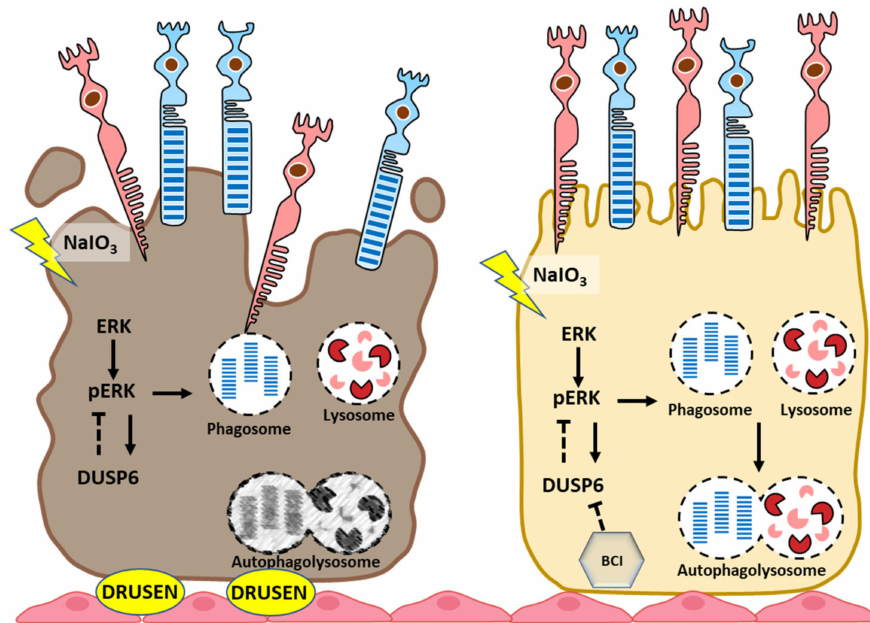
Figure S3: Immunohistochemical examinations of the expression of Iba1 in NaIO 3 -treated mice retina. Representative immunohistochemical staining for Iba-1 (red) and DAPI (blue) 7 days after injection with 30 mg/kg of NaIO 3 . Iba-1 were used for microglial markers. Scale bar = 20 µ